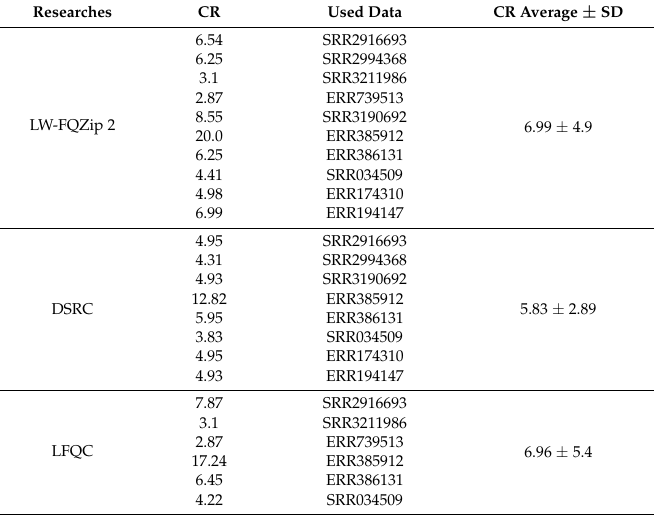
Table 4. CR Comparison between BAQALC and Related